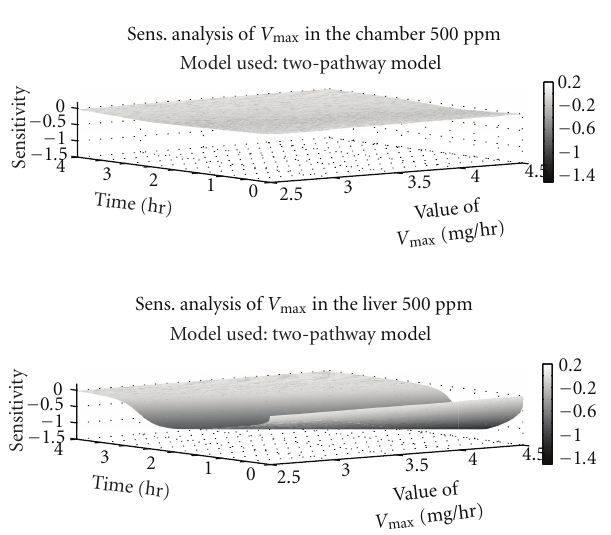
Figure 7: Three-dimensional sensitivity analysis plot for the two-pathway model at 500